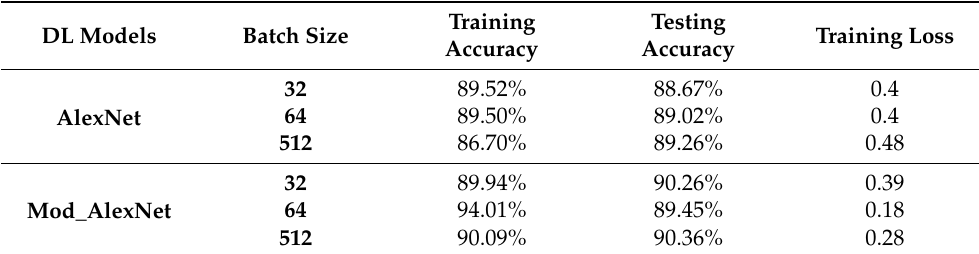
Table 6. Adam optimizer performance (3 epochs and batch sizes: 32, 64, and